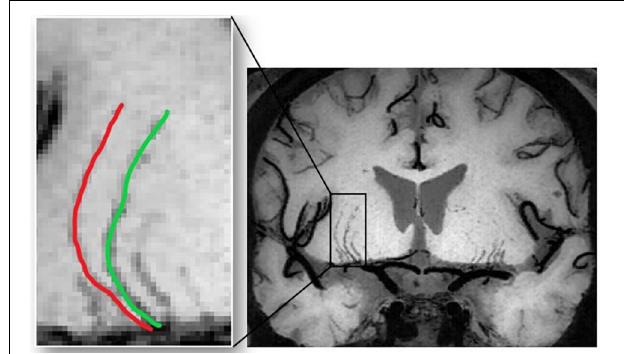
FIGURE 1 | The images are coronal 10-mm thin-slice minimum intensity projections of 3D black blood MRI for presentation. LSAs were manually delineated on the images and morphological measurements were calculated